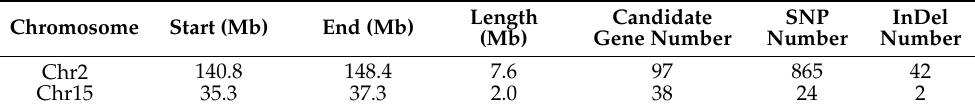
Table 3. Linkage intervals associated with candidate genes of seed ratio.